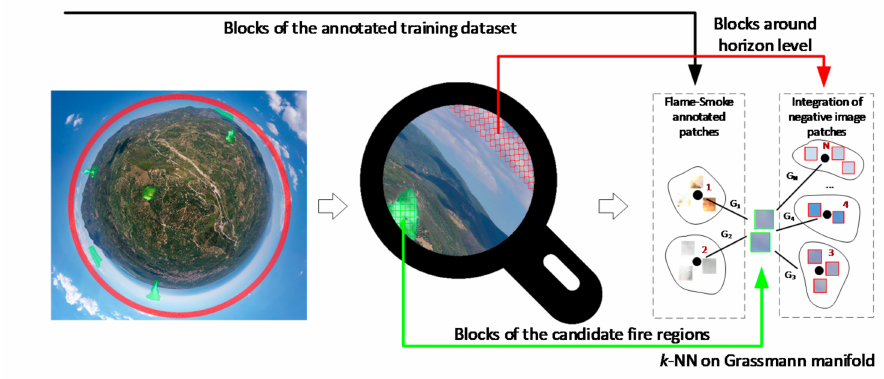
Figure 5. The proposed adaptive validation scheme.